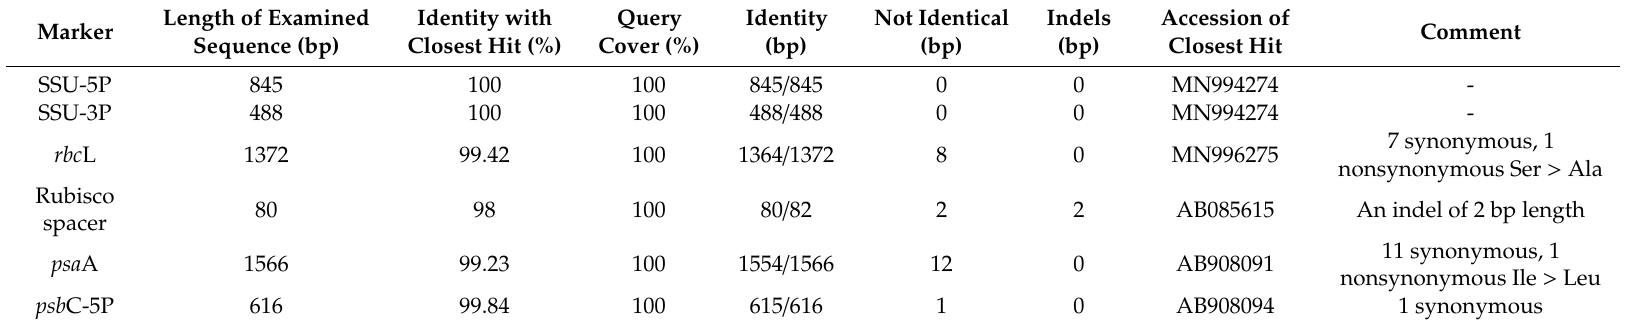
Table 2. Results of BLAST searches [35] for sequences of Schizocladia from Rhodes. The best hit was in all cases the previous isolate of S. ischiensis from Ischia, KU-333